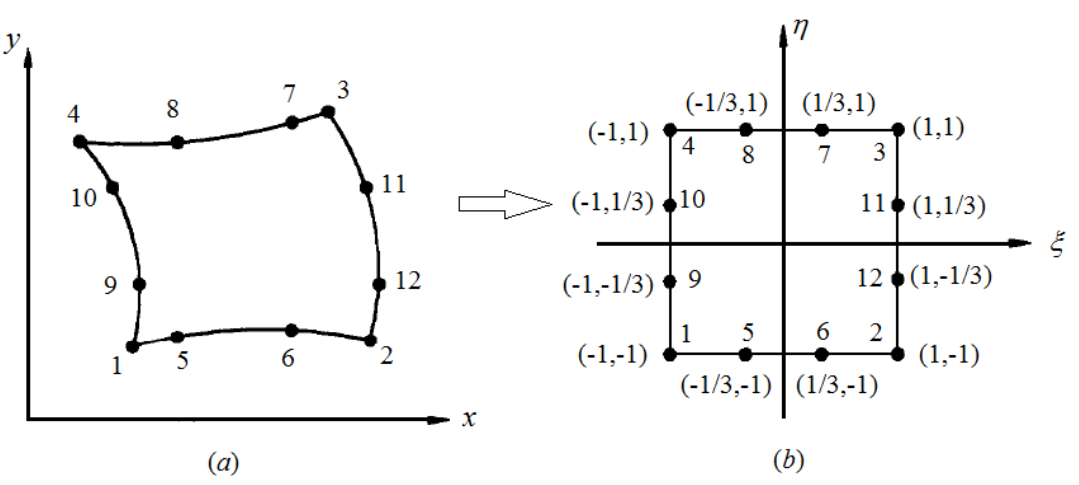
Fig. 1 12 node transformation mapping of a medium with irregular